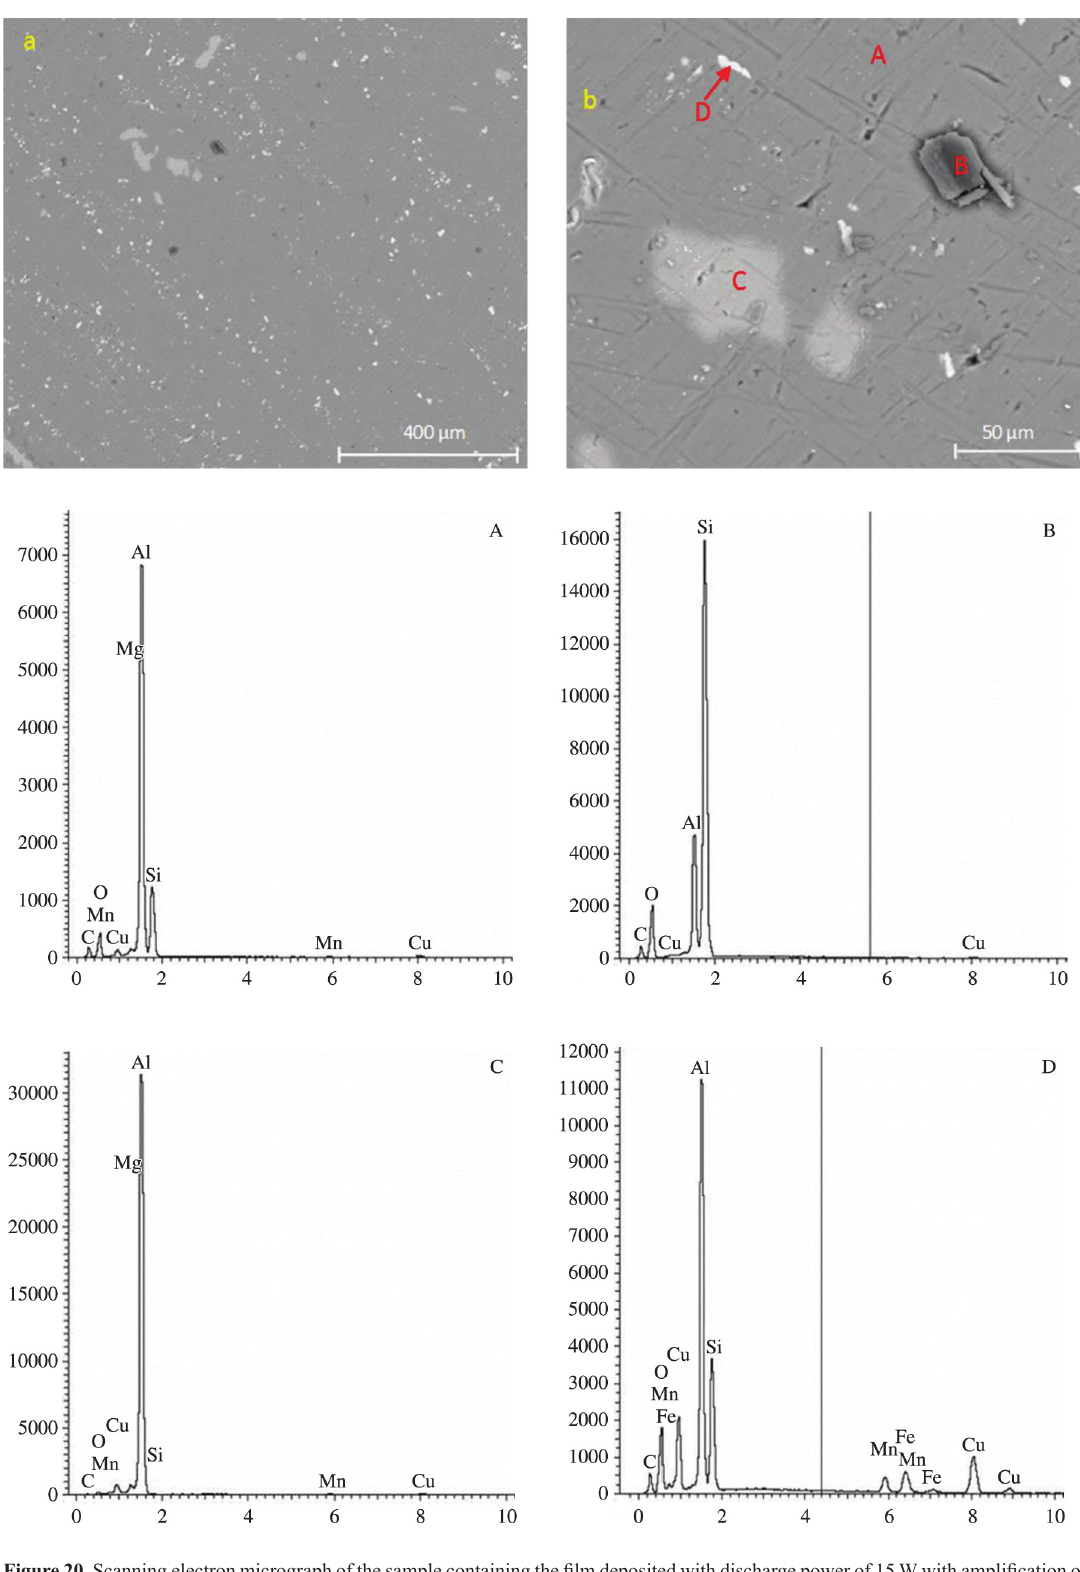
Figure 20. Scanning electron micrograph of the sample containing the film deposited with discharge power of 15 W with amplification of (a) 250 times and (b) 1500 times. A, B, C and D are energy dispersive spectra of the regions A, B, C and D of the micrograph shown in